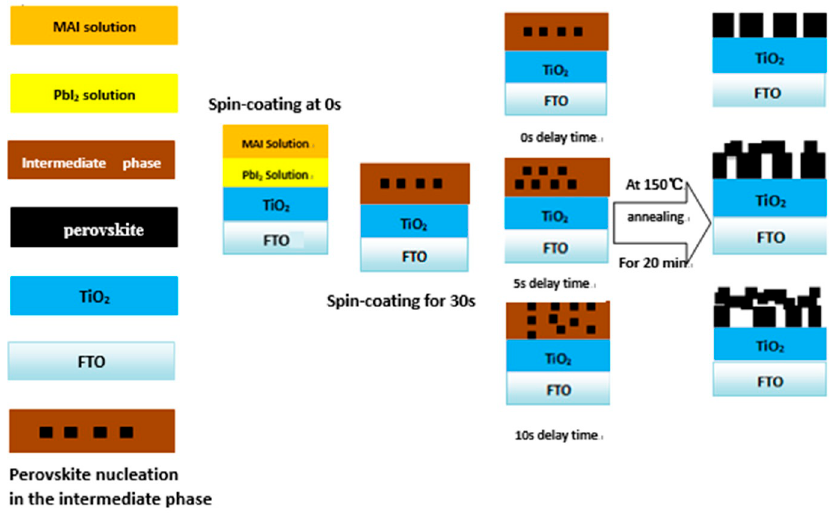
Figure 3. The mechanism diagram of perovskite film formation with different delay times.